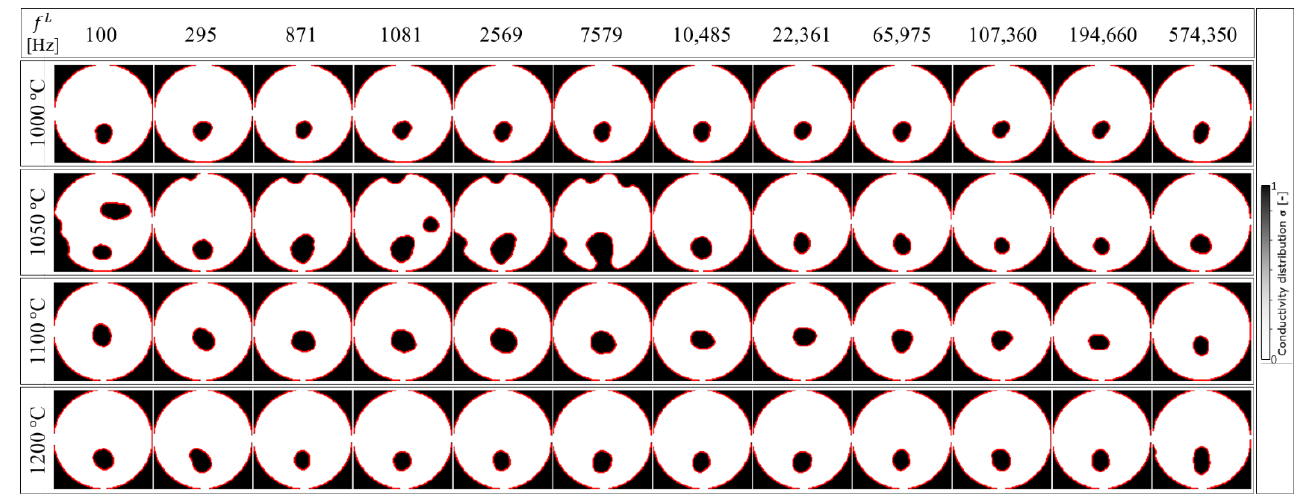
Figure 12. Image edge detection using the Chan-Vese segmentation algorithm.